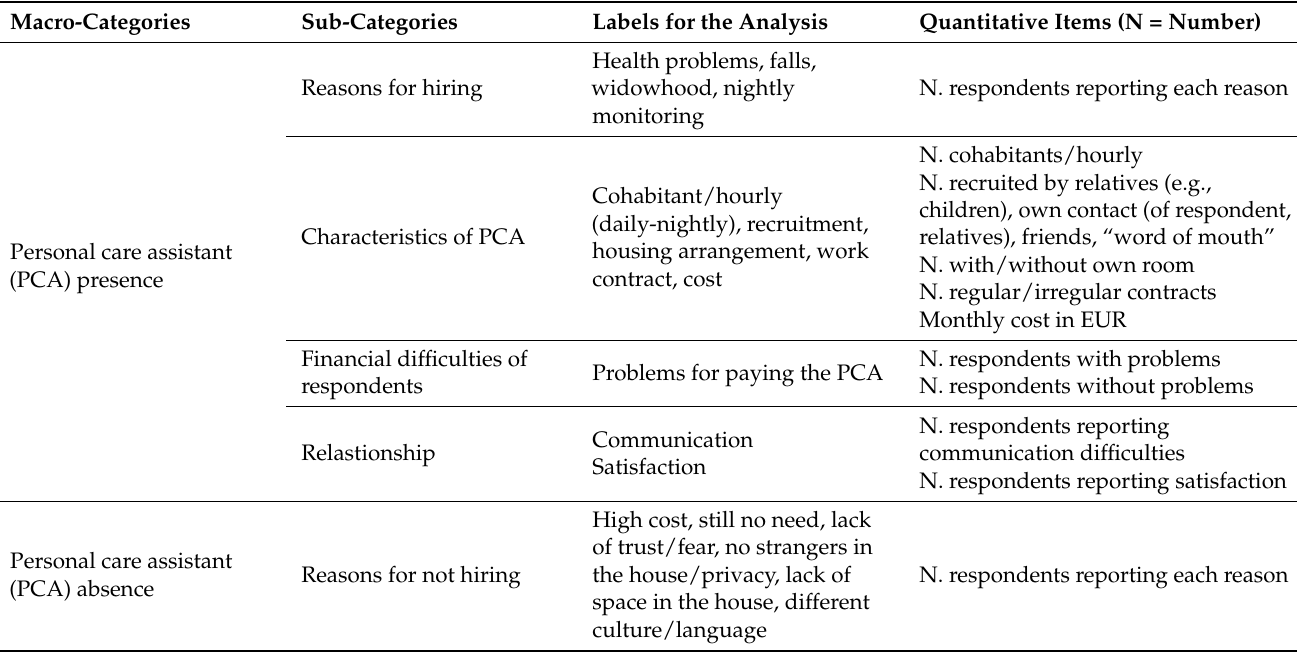
Table 1. Categories, labels, and quantitative